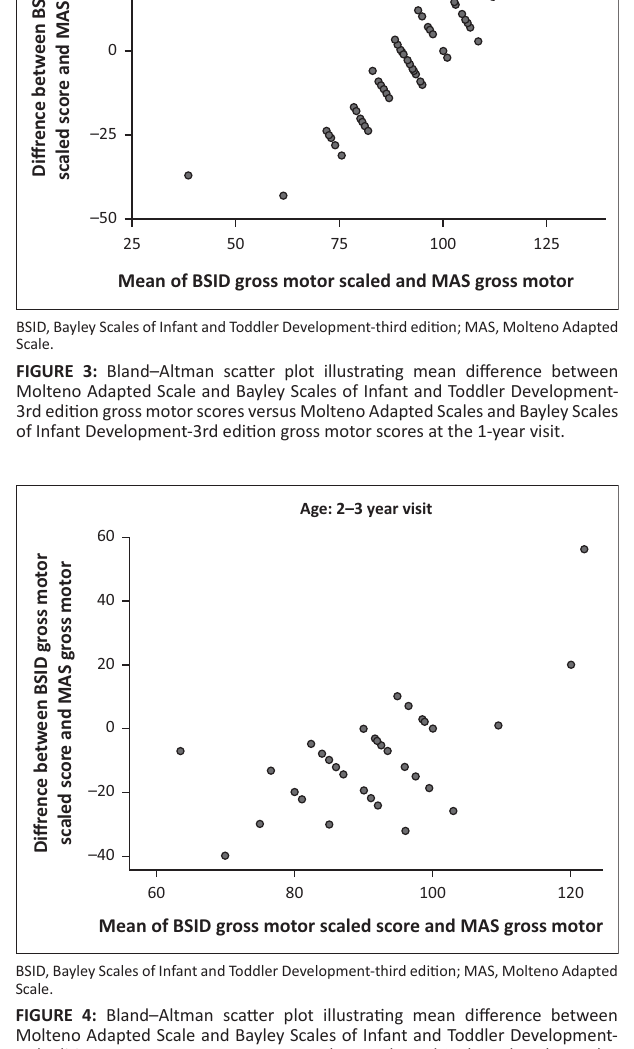
FIG URE 4: Bland–Altman scatter plot illustrating mean difference between Molteno Adapted Scale and Bayley Scales of Infant and Toddler Development- 3rd edition gross motor scores versus Molteno Adapted Scale and Bayley Scales of Infant Development-3rd edition gross motor scores at the 2–3-year visit.